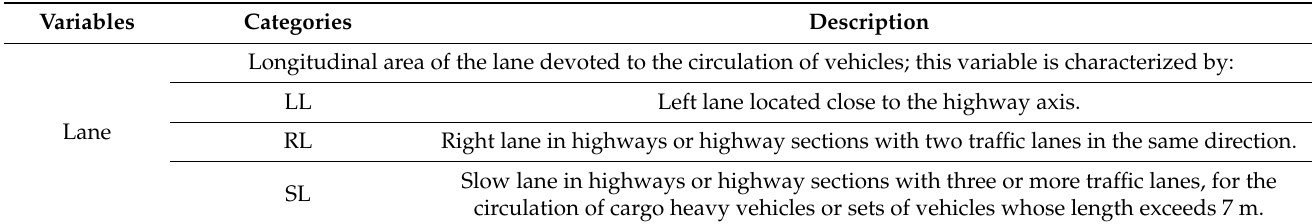
Table 4. Explanatory variables of the characteristics of the